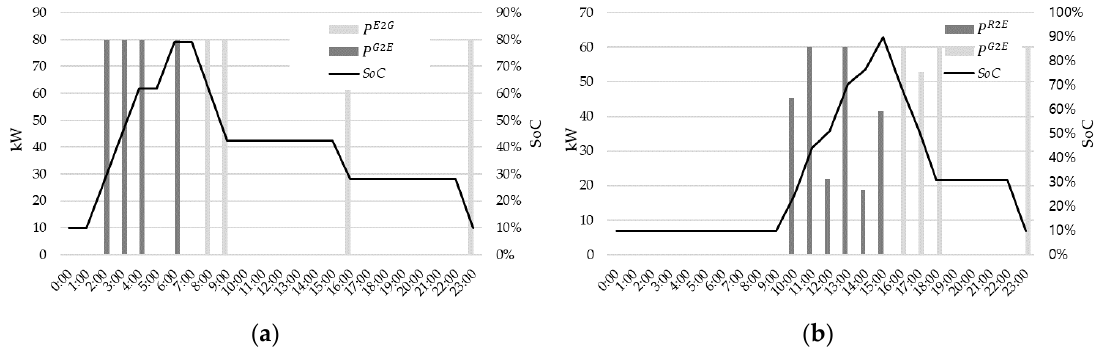
Figure 8. Change in the charging, discharging, and SoC of ( a ) independent ESS and ( b ) combined ESS.